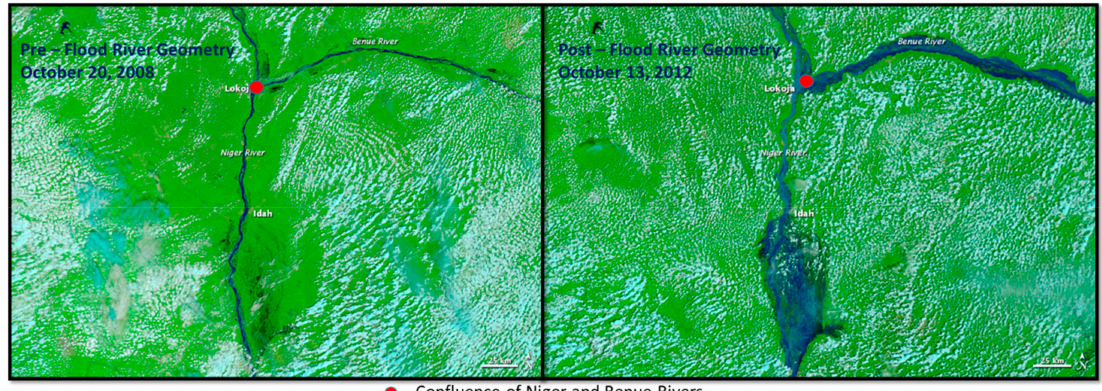
Figure 2. NASA’s Terra (Moderate Resolution Imaging Spectroradiometer) satellite images